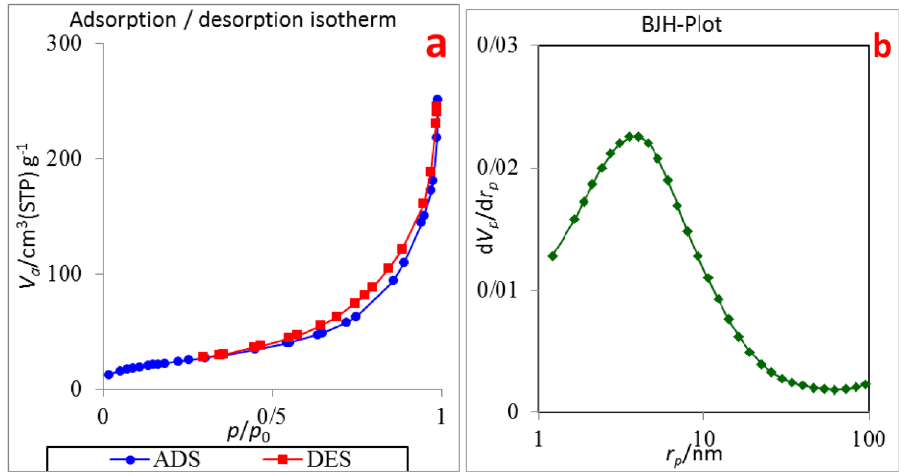
Figure 7. ( a ) N 2 adsorption–desorption isotherm and ( b ) BJH-Plot of Cu(II)-MP-bis(AMP)@boehmite.